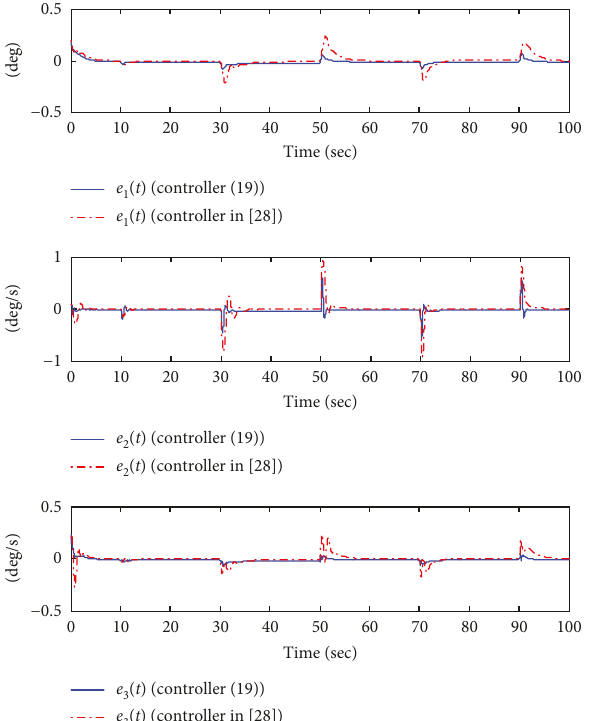
Figure 2: Trajectories of state tracking error e ( t ) .